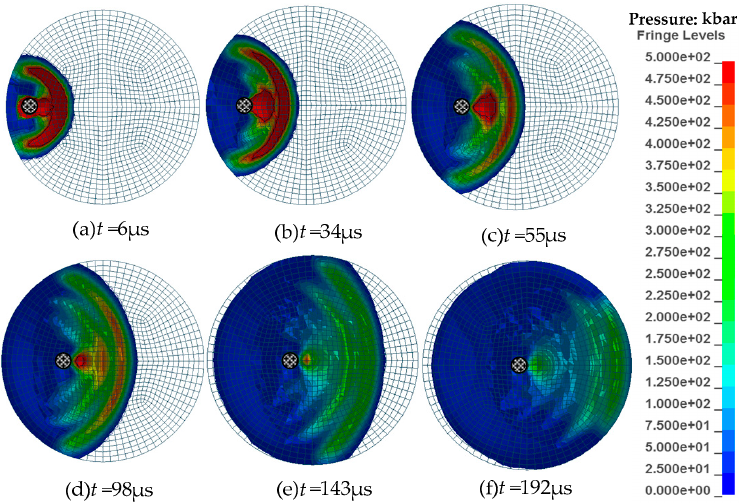
Figure 9. The pressure nephogram of the shock wave in satellite tank at 6 µ s, 34 µ s, 55 µ s, 98 µ s, 143 µ s, and 192 µ s .